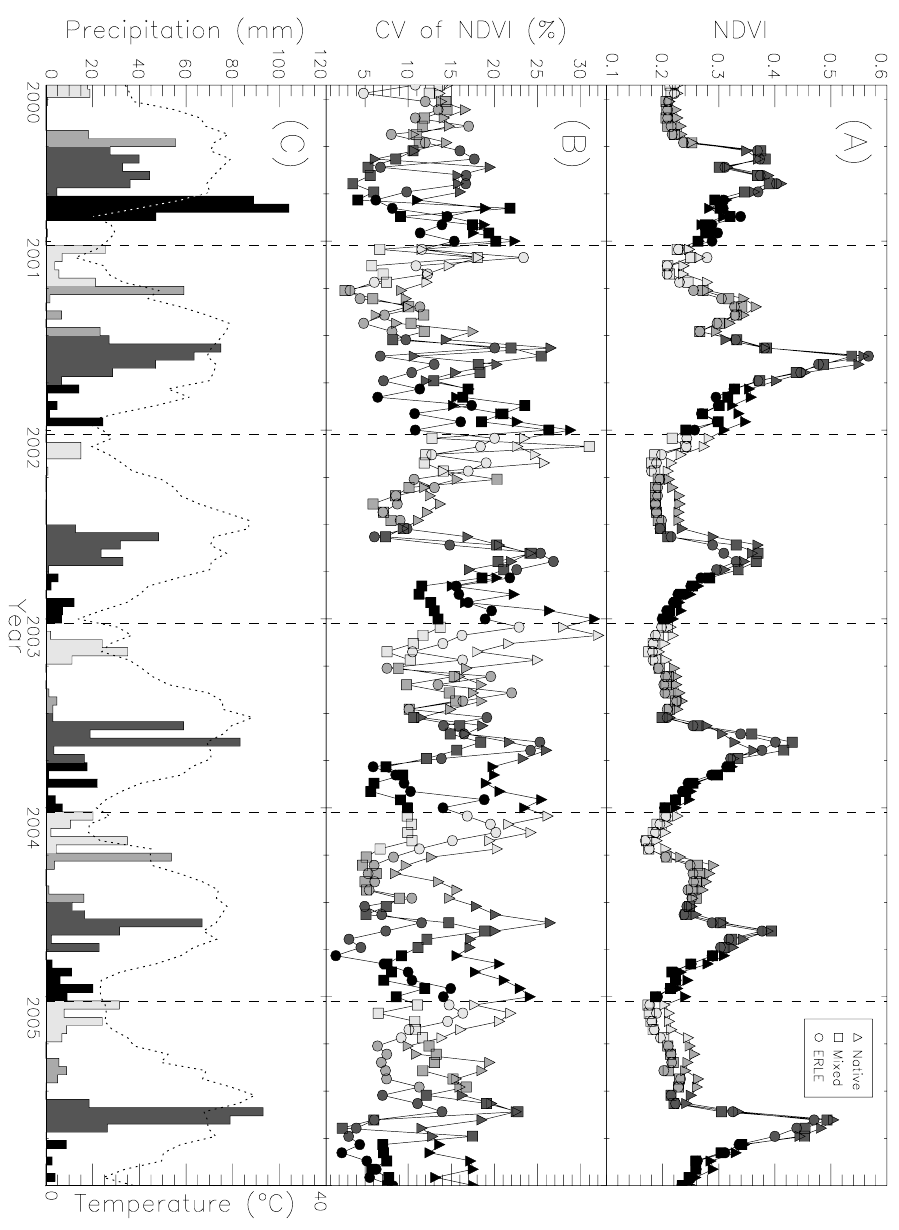
Figure 1. (A) The Normalized Difference Vegetation Index (NDVI) time-series data for Native, Mixed, and Eragrostis lehmanniana (ERLE) sites from 2000 to 2005. (B) Spatial variations of NDVI through time among sites demonstrated using the coefficient of variation (CV). (C) Bi-weekly precipitation (bars) and temperature (dotted line) data based upon daily weather records from five stations at the desert grasslands of southern Arizona, USA. Months are evenly divided by four intervals with colors from bright to dark. This figure is adapted from Huang et al . [45] with permission from Taylor &